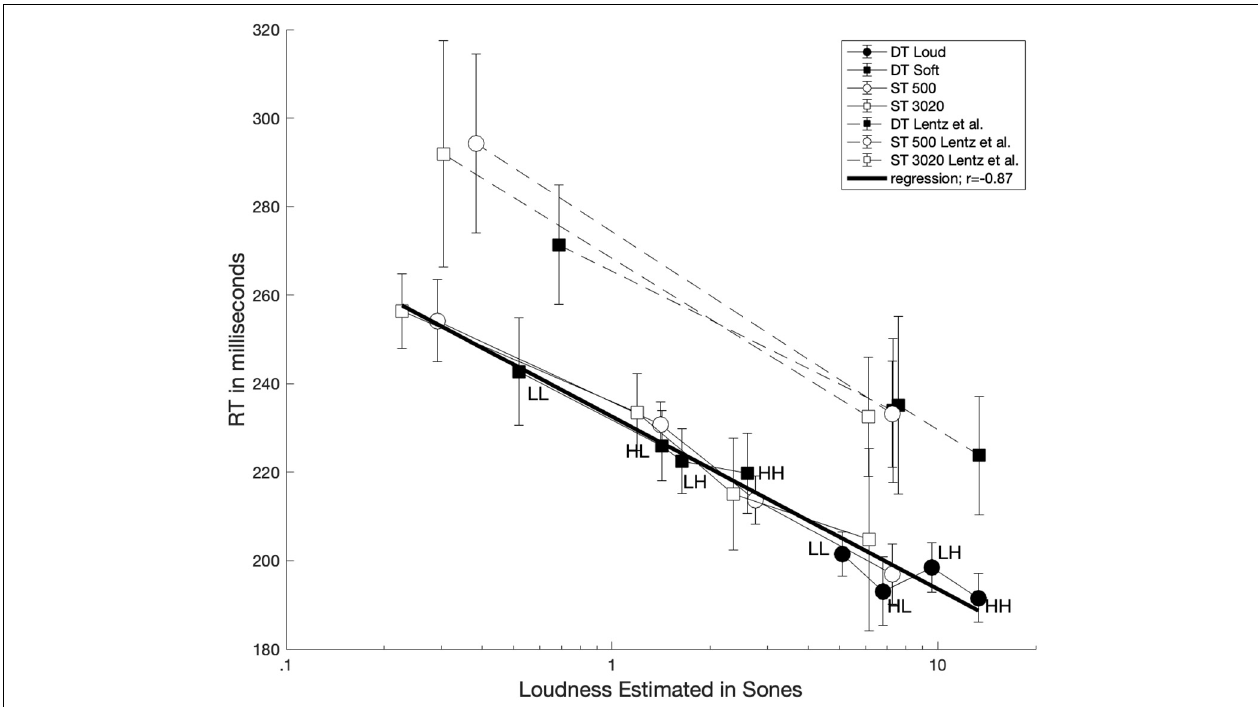
FIGURE 4 | Average reaction time plotted as function of loudness estimated from Moore and Glasberg’s loudness model. Data from single-target and dual-target conditions are illustrated with unfilled and filled symbols, respectively. The solid dark line represents a log-linear regression line using the current data